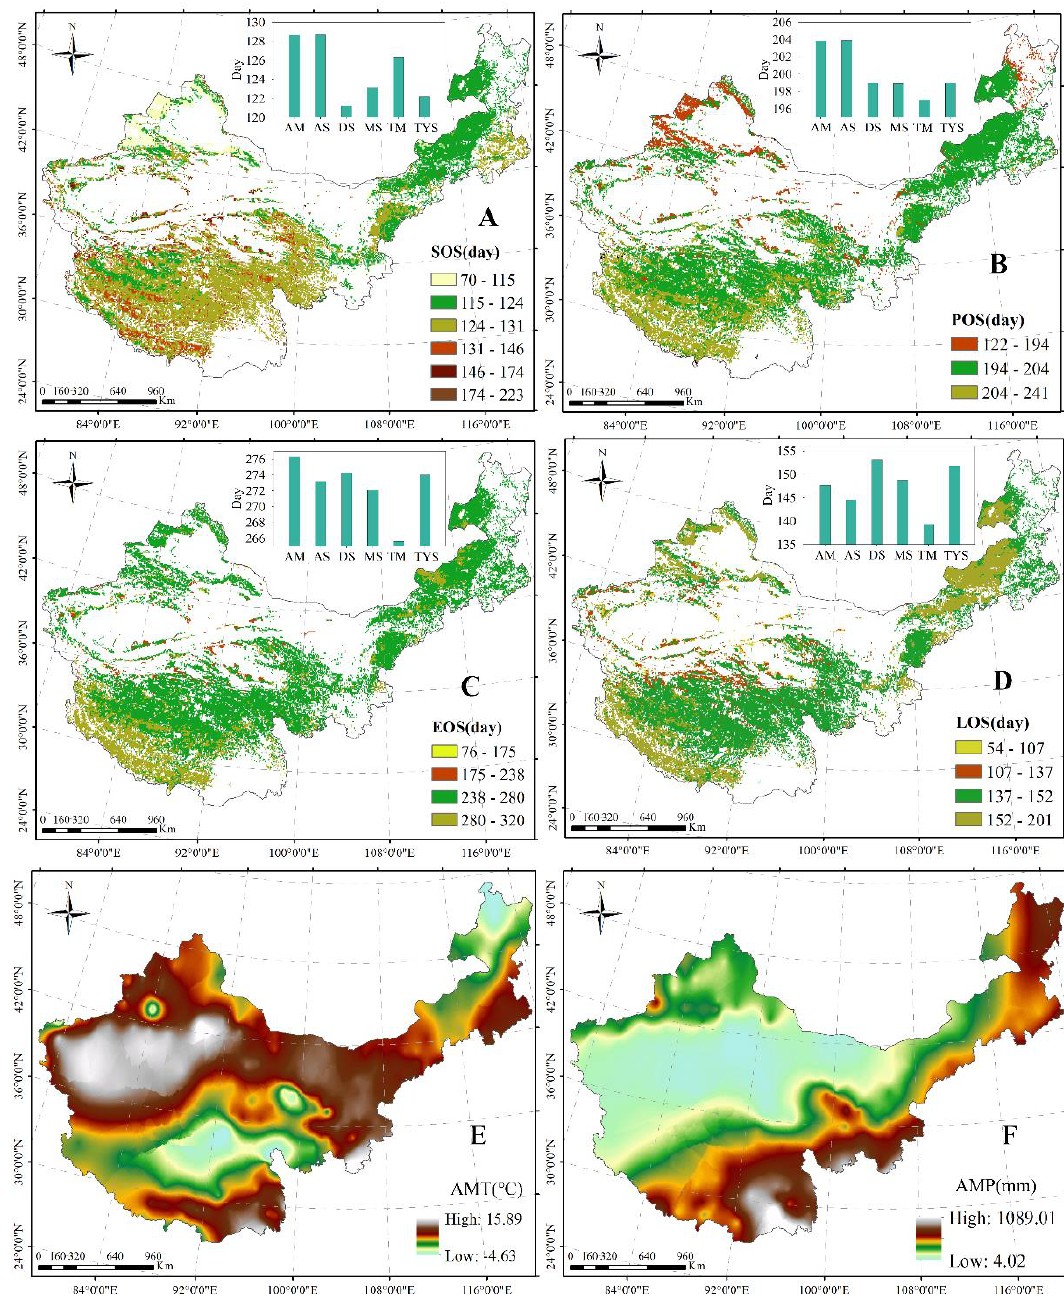
Figure 3. Average spatial distribution of the grassland SOS ( A ); POS ( B ); EOS ( C ); LOS ( D ); annual mean temperature (AMT) ( E ); and annual mean precipitation (AMP) ( F ) between 1985 and 2010 in northern China. AM, AS, DS, MS, TM, and TYS represent the alpine meadow, alpine steppe, desert steppe, meadow steppe, temperate meadow, and typical steppe, respectively.